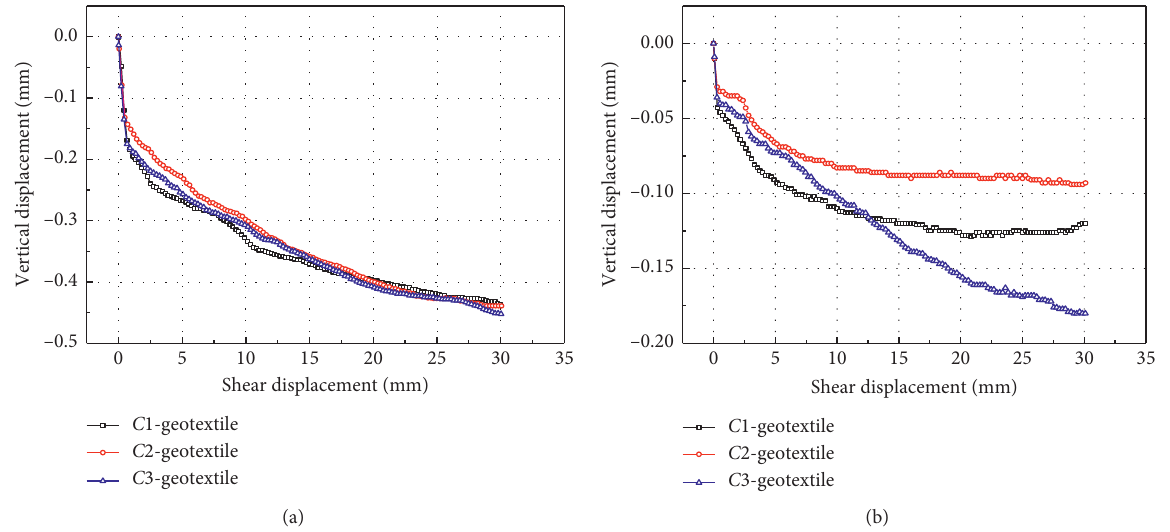
Figure 7: Effect of sand particle size on the interface vertical displacement-shear displacement curves in the (a) MDS and (b) PCDS